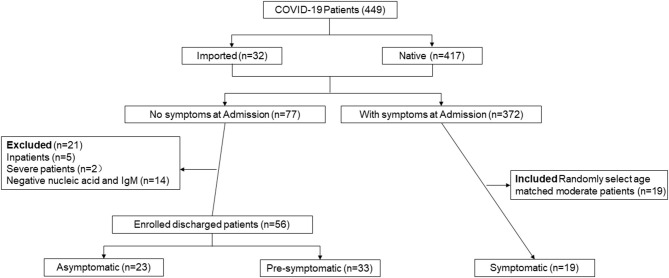
Participant profile. The figure depicts the study design and general inclusion criteria of the study.